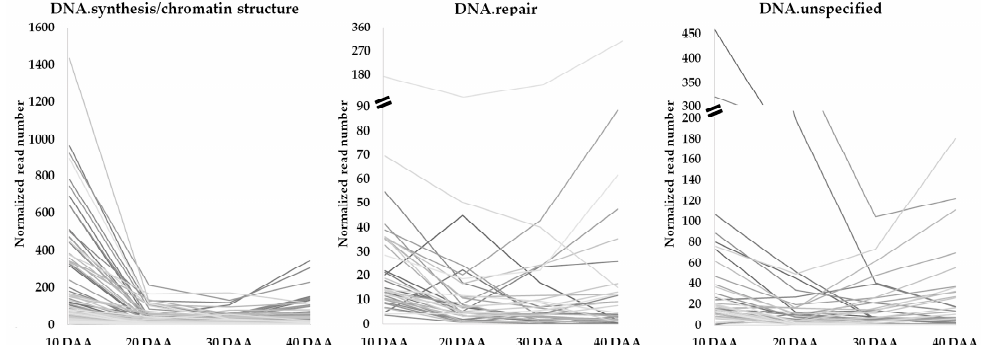
Figure 2. Profiles of expressed genes classified in the MapMan functional “DNA” subcategories during P. vulgaris seed development. Grey lines depict expression profiles for each individual gene in the subcategory with at least two-fold change in the expression.